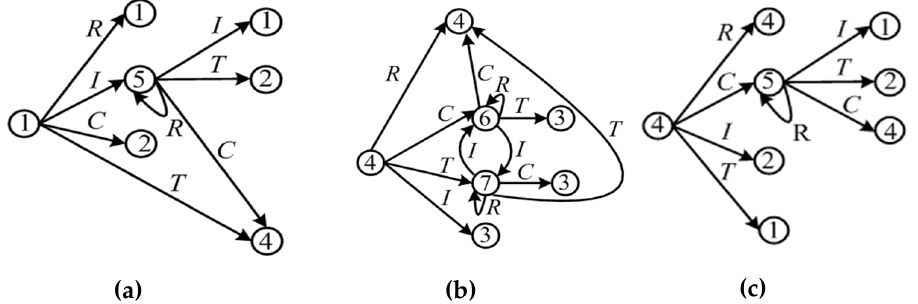
Figure A1. ( a ) The signal is input from port 1 to coupled line A; ( b ) The signal is input from port 4 to coupled line B; ( c ) The signal is input from port 4 to coupled line A.